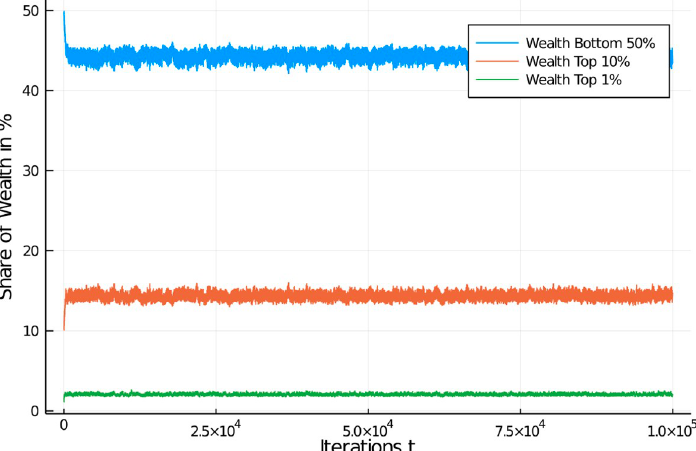
Fig 11. Wealth tax effects on quantiles. Wealth development in different quantiles of the population of 1,000 agents. Initial distribution was equal among all 1,000 agents. Quantiles shown: Bottom half of the population vs top 10% and top 1% wealthiest